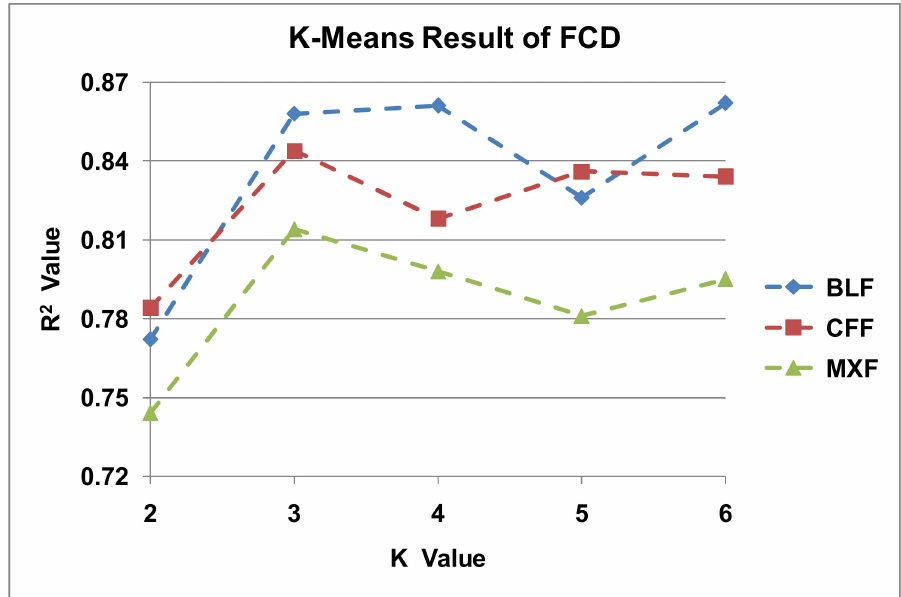
Figure 8. K-means clustering results of FCD.